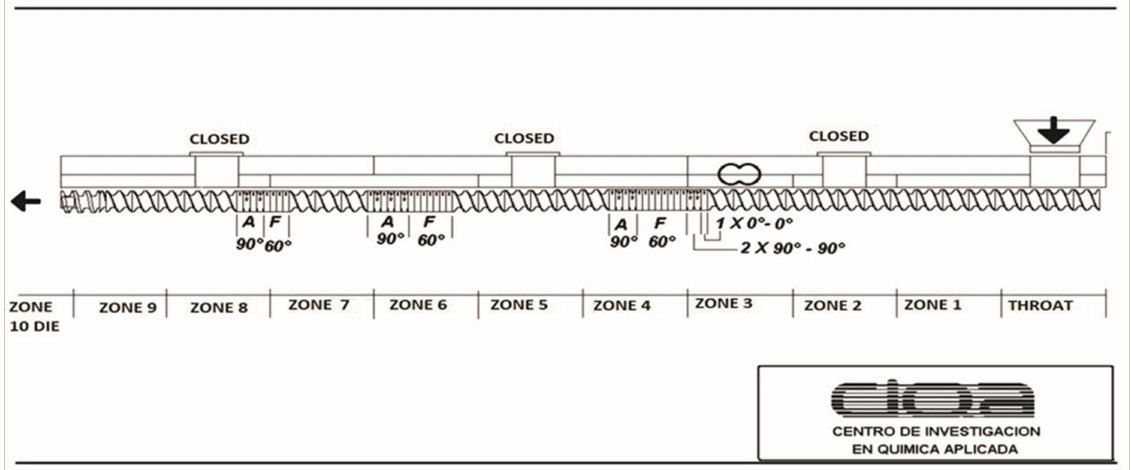
Figure 1. Screw mixing setup used during